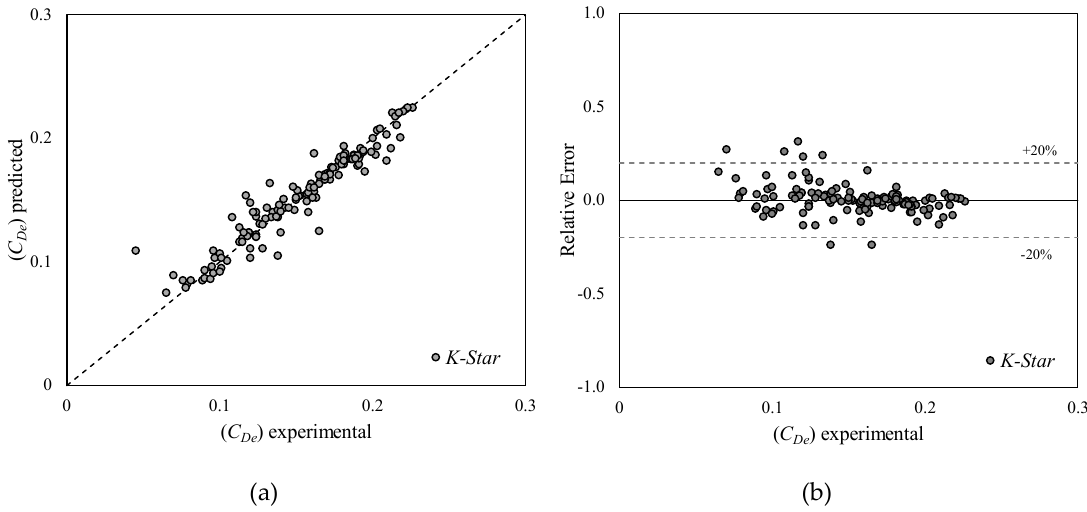
Figure 5. Model 1, K-Star algorithm, ( a ) predicted versus experimental results, and ( b ) relative error versus experimental results.